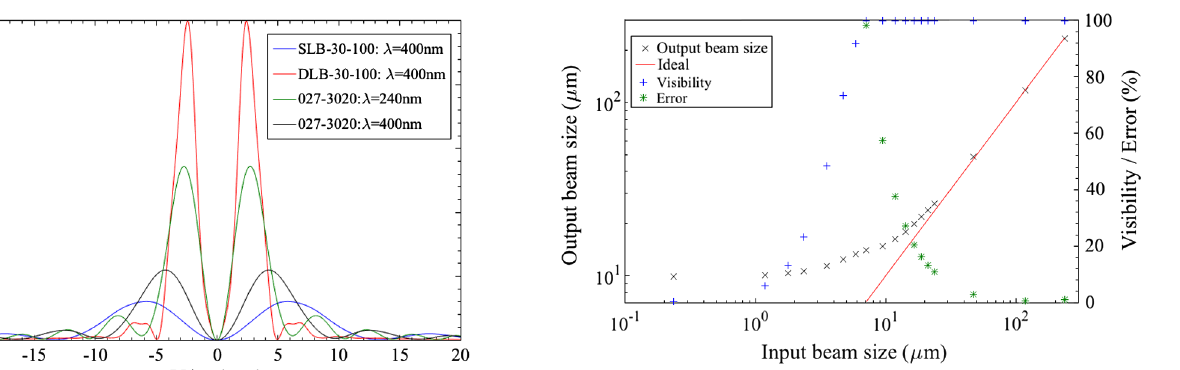
FIG. 6. OTR PSF distribution calculated by ZEMAX for different types of lenses and for γ ¼ 2500 .